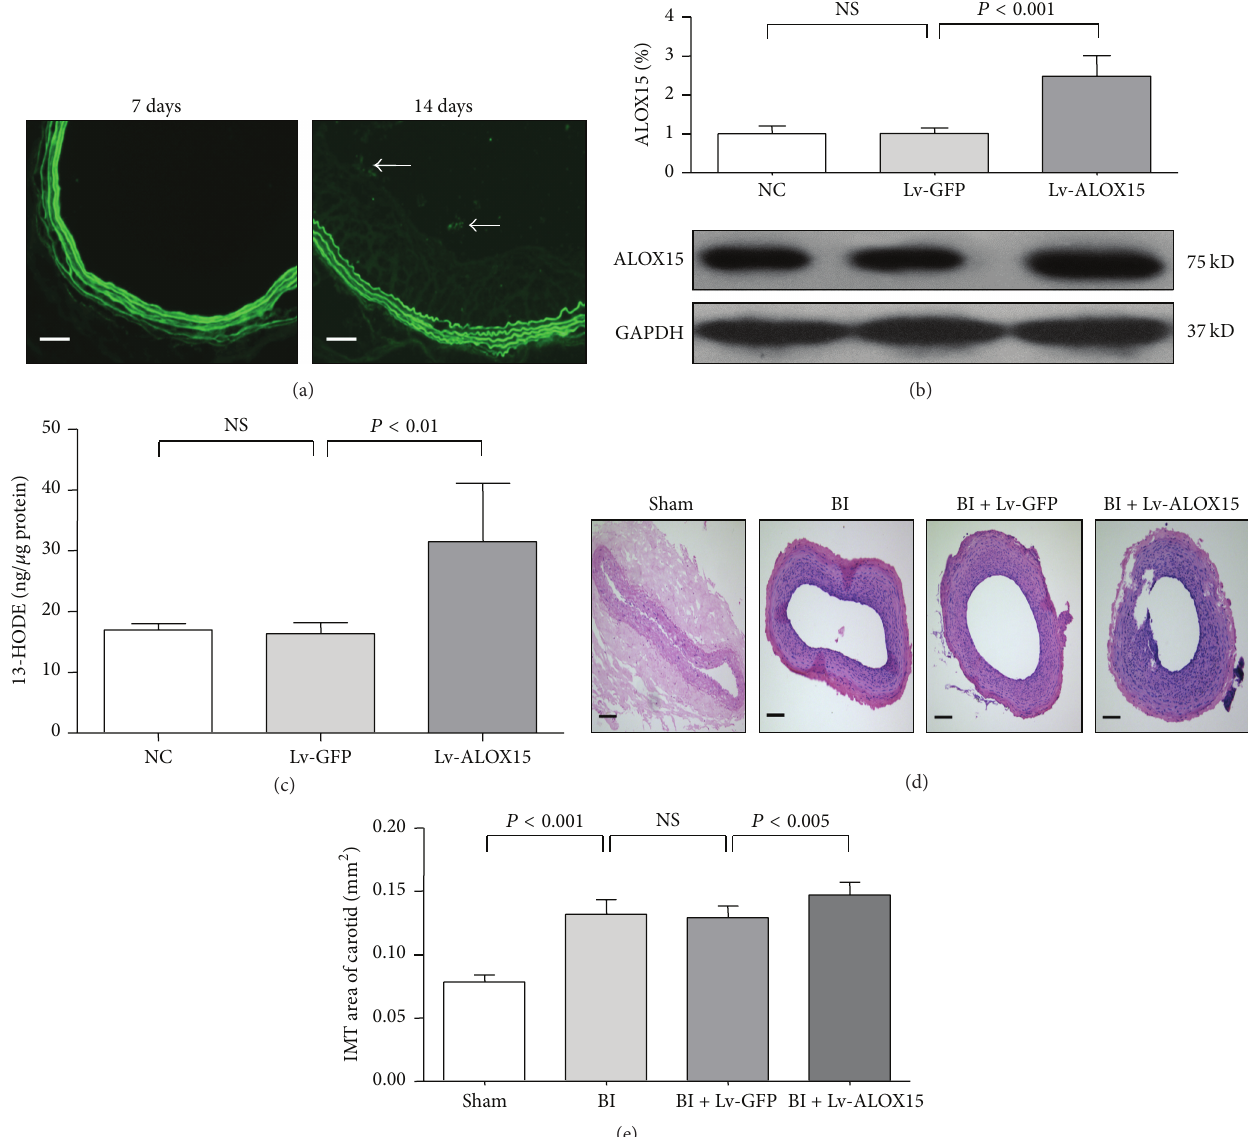
Figure 1: Lentivirus-based ALOX15 overexpression in the rat carotid artery and the effect of ALOX15 on neointima formation in rat balloon- injured (BI) carotid arteries. (a) Representative images showing no detectable green fluorescence after 7 days, but pronounced fluorescence after 14 days, in the neointima of carotid arteries after transfection with lentiviral constructs coexpressing GFP. (b) Western blot analyses showed that Lv-ALOX15 upregulated ALOX15 protein expression. (c) EIAs showed that Lv-ALOX15 upregulated linoleic acid metabolite 13- HODE.(d)ImmediatelyafterBI,arteriesweretreatedwithnormalsaline,Lv-GFP,orLv-ALOX15.Representativephotomicrographsofcarotid arteries 14 days after BI. The artery cross sections were stained with HE. (e) Quantitative analysis of IMT. The arrows indicate endothelial cells expressing GFP. The scale bar represents 100 𝜇 m. Results are expressed as mean ± SD. NS: not significant. 𝑁 = 4 or 6 per